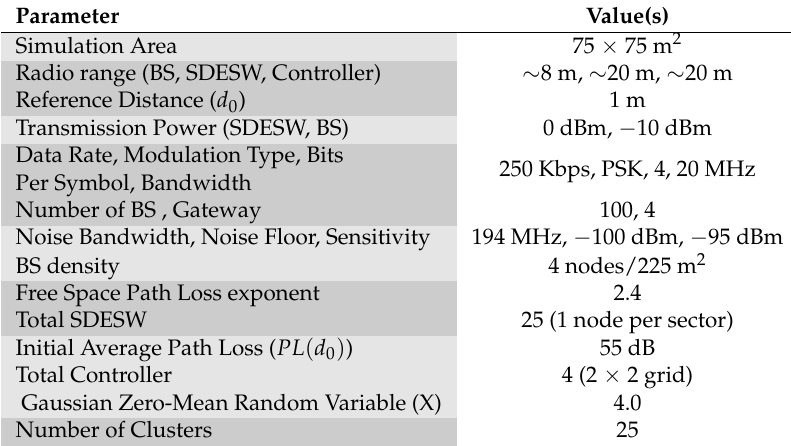
Table 7. Simulation Parameters (adapted from our previous work Hasan et al.